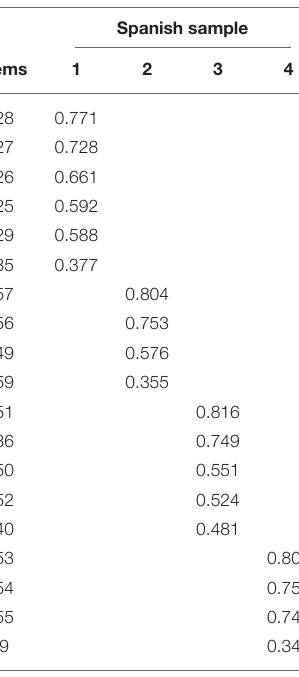
TABLE 3 | Distribution of the definitive items for the proposed dimensions and theoretical